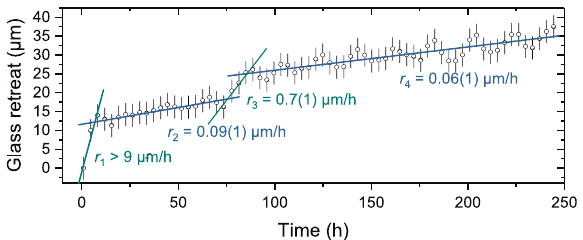
Fig. 5 Glass dissolution rate regimes. Retreat of the silica – glass interface as a function of time, showing four different kinetic regimes. The given rates r 2 , r 3 , and r 4 were obtained by a linear least- squares fi t to the data. However, r 1 was estimated considering that a ~90- μ m-thick silica had already formed before the fi rst image was taken. The glass retreat is given by the shift of the position of silica – glass interface compared to its position in the fi rst image at t = 1.0 h. The undulation on the fi tted position is an artefact of the mechanical x – y – z table. Errors bars re fl ect the two-sigma errors.